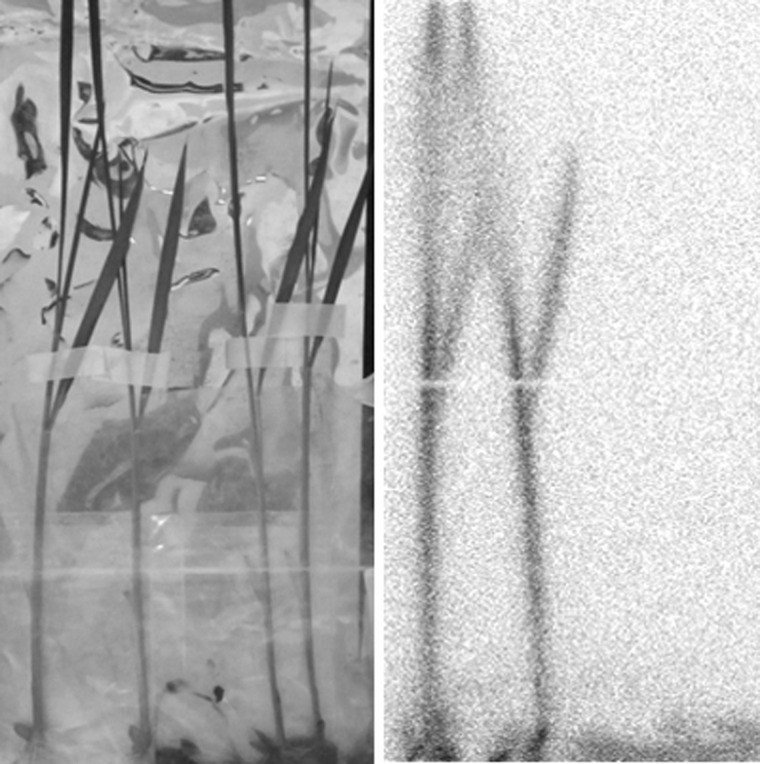
Comparison between soil culture and water culture with respect to 137Cs uptake [1,2]. Rice plants were grown in soil and water culture. 137Cs was supplied in both cultures, and the manner of uptake by the roots was compared using the real-time imaging system developed. In the case of the soil culture, the 137Cs was firmly adsorbed onto the soil; thus, the 137Cs was not absorbed by roots. However, in the case of the water culture, the 137Cs was rapidly absorbed by the roots. Left: photo; right: autoradiograph after 3 h. The two plants on the left of each image were grown in water culture and the two plants on the right were grown in soil (N.I. Kobayashi et al.).